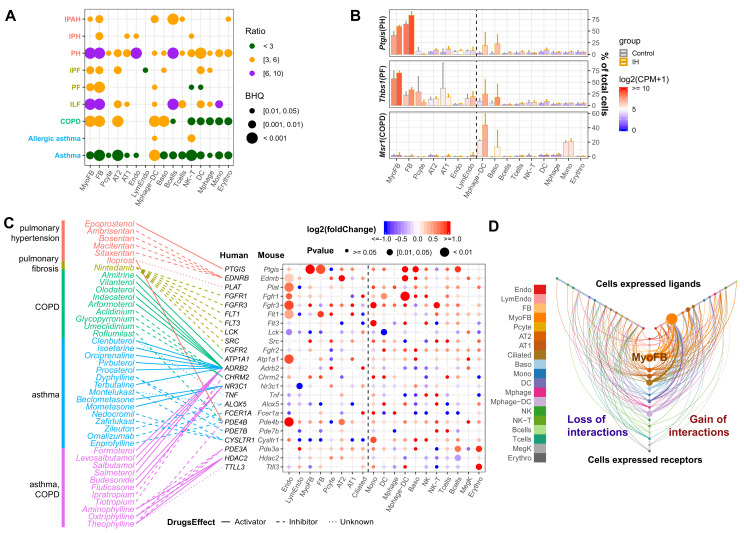
Pulmonary disease-regulated genes provide clinical implications for OSA at the cell-specific level.(A) Pulmonary disease-associated genes are enriched in upregulated genes in different cell types from whole lungs of mice exposed to IH vs controls. Enrichment analysis was performed in the DisGenet human database, using the top 200 upregulated genes identified from each cell type. The enrichment ratio is indicated by color. The point size indicates the enrichment BHQ from a Fisher’s exact test. The pulmonary diseases include asthma, allergic asthma, chronic obstructive airway disease (COPD), interstitial lung fibrosis (ILF), pulmonary fibrosis (PF), idiopathic pulmonary fibrosis (IPF), pulmonary hypertension (PH), idiopathic pulmonary hypertension (IPH), and idiopathic pulmonary arterial hypertension (IPAH). (B) The disease-associated genes vary in expression level and percentage of cells that express those genes. The fold change is indicated by the color, and the percentage of cells that express those genes is indicated by the height of the bar. Control and experimental groups are indicated by gray and orange box borders, respectively. (C) Dozens of pulmonary drug targets show differential expression in multiple cell types in lungs from mice exposed to IH. Drug classes used to treat different pulmonary diseases are indicated by text color. Drug effect is indicated by the line type. Fold change is indicated by the point color, and the p-value of differential expression is indicated by the point size. (D) The hive plot shows ligand–receptor interaction changes between pairs of cell types in response to IH. Nodes indicate cell-expressed ligands (horizontal axis) or receptors (vertical axis). Size of nodes are in proportion to the number of interactions changed for the cell type. Width of lines show numbers of interactions gained (right) or lost (left) between the pairs of cell types. The list of cell types include endothelial cells (Endo), B cells (Bcells), natural killer cells (NK), T cells (Tcells), natural killer T cells (NK-T), macrophages (Mphage), basophils (Baso), monocytes (Mono), macrophages-dendritic CD163+ cells (Mphage-DC), dendritic cells (DC), megakaryocytes (MegK), fibroblasts (FB), myofibroblasts (MyoFB), pericytes (Pcyte), alveolar epithelial type I cells (AT1), lymphatic endothelial cells (LymEndo), erythroblasts (Erythro), alveolar epithelial type II cells (AT2), and ciliated cells (Ciliated).Figure 6—source data 1.Numerical data for Figure 6, Figure 6—figure supplements 1–5.